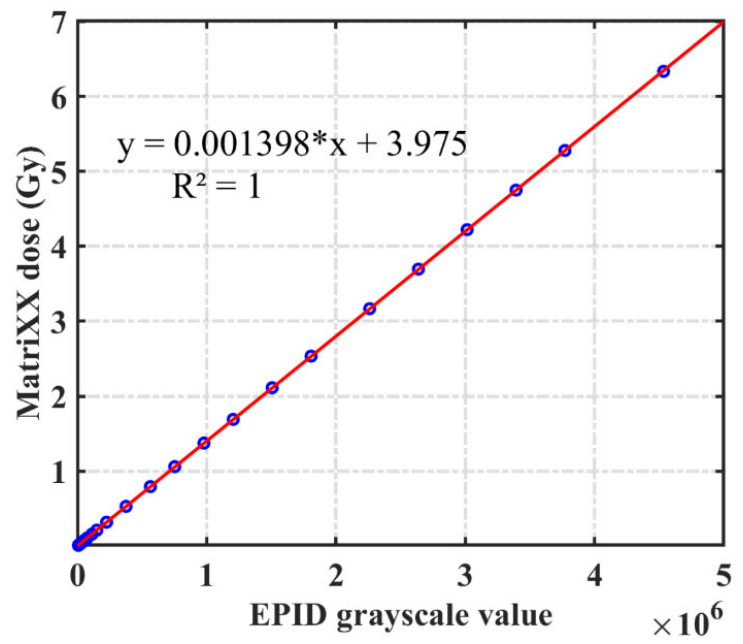
Figure 6. Pixel value and dose conversion function of the central axis in 24 cm 2 field. Table 1. Pixel and dose conversion coefficients for different off-axis distances of corrected and uncorrected EPID.